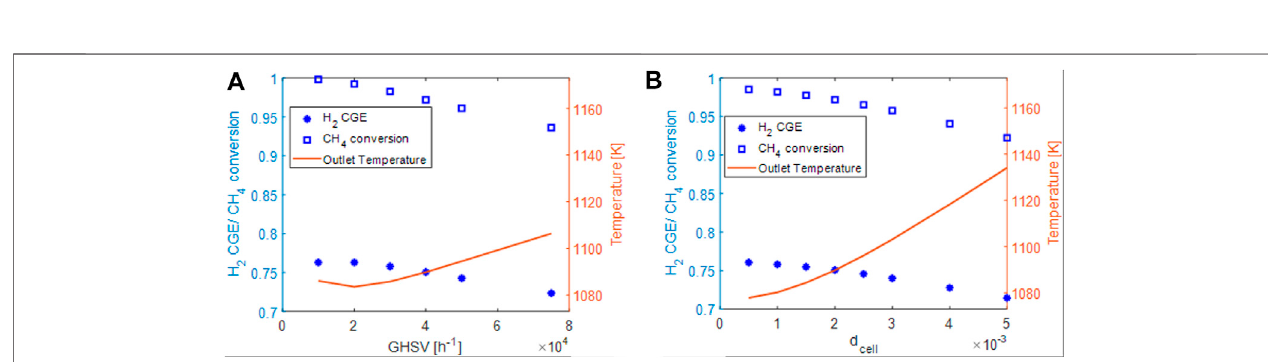
FIGURE 8 |(A) effect ofspace velocity on conversion (blue squares), Hydrogen cold gasef fi ciency (blue asterisks) and outlet solid temperature (red line). (B) effect of the CPSI on conversion (blue squares), Hydrogen cold gas ef fi ciency (blue asterisks) and outlet solid temperature (red line).